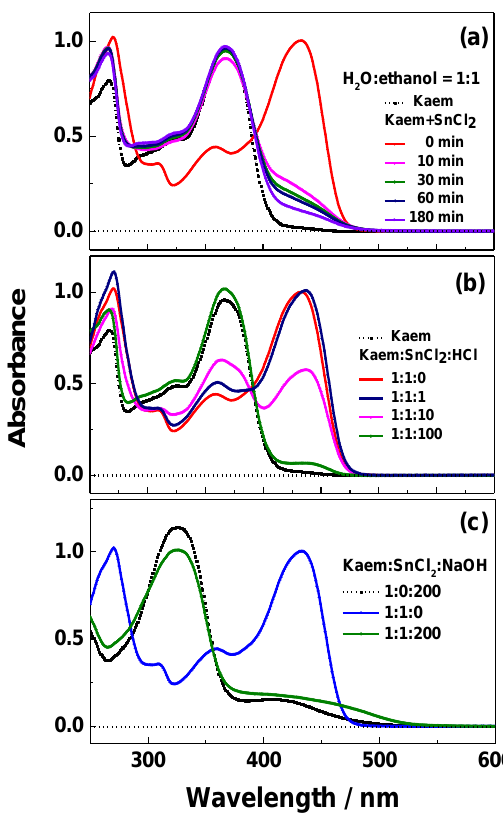
Figure 4. Effects of addition of water, acid, and base on the stability of the [Sn(II)(Kaem) 2 ] complex. Absorption spectra of solution of 50 µM HKaem and 50 µM SnCl 2 measured ( a ) in water:ethanol = 1:1, v/v, and in ethanol by addition of ( b ) 50, 500, and 5000 µM hydrochloric acid and ( c ) 1 mM sodium hydroxide. Absorption spectra of 50 µM HKaem alone under the same conditions is indicated by a dashed line for comparison.